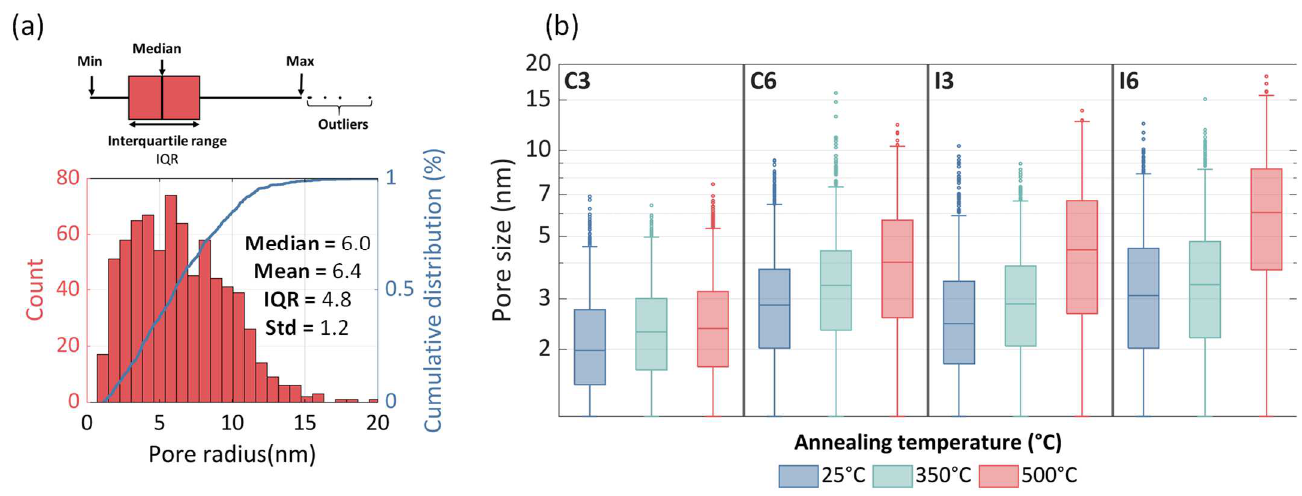
Figure 5. ( a ) Pore-size distribution and boxplot calculated for the I6 film annealed at 500 °C. ( b ) Boxplots showing the evolution of the pore size for all SnO 2 thin films sputter deposited before and after an annealing treatment in air for 48 h and at 2 different temperatures (350 and 500 °C).